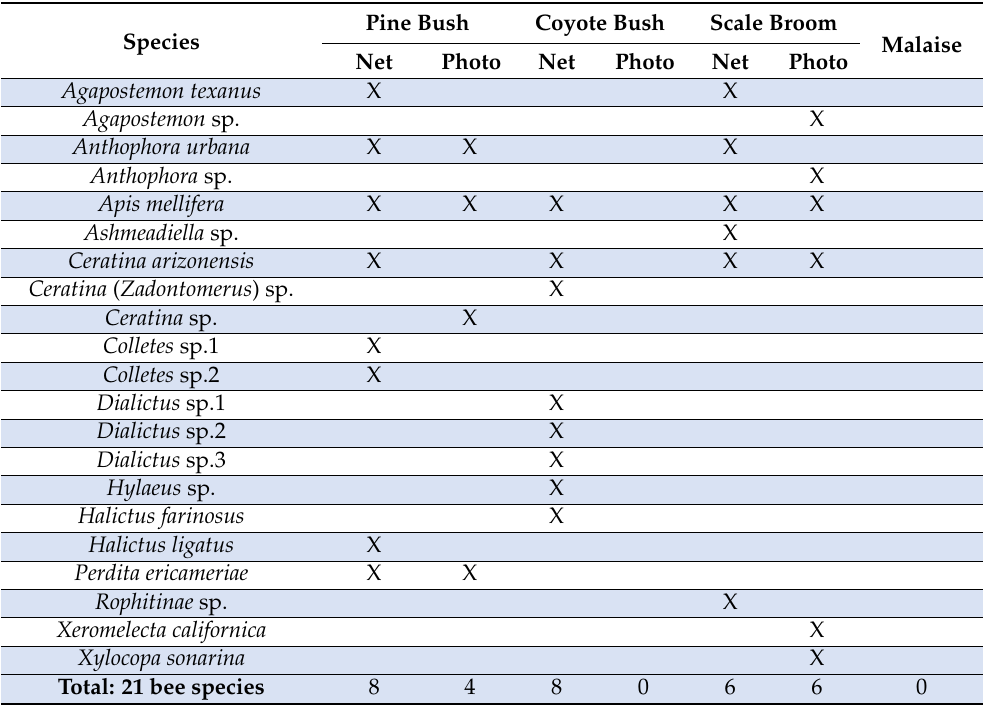
Table 3. Bees of E. pinifolia (pine bush), B. pilularis (coyote bush), and L. squamatum (scale broom). Pine Bush Species